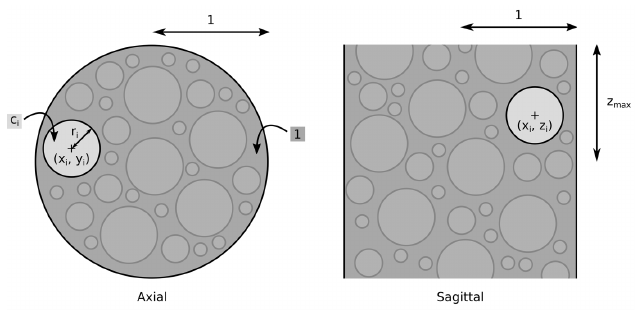
Figure 2 Schematic representation of a foam phantom, with an axial ( i.e. horizontal) slice shown on the left, and a sagittal ( i.e. vertical) slice shown on the right. The radius of the main cylinder is fixed to 1, with all other distances defined relative to this radius. Similarly, the attenuation coefficient of the main cylinder is fixed to 1 as well. Each void is characterized by its position x i , y i , and z i , its radius r i , and its attenuation coefficient c i . For one highlighted void, these parameters are shown in the figure. The vertical size of the phantom is defined by z max . Note that z max limits the position of the center of each void, which means that parts of a void can exist at positions larger than z max or smaller than (cid:5) z max